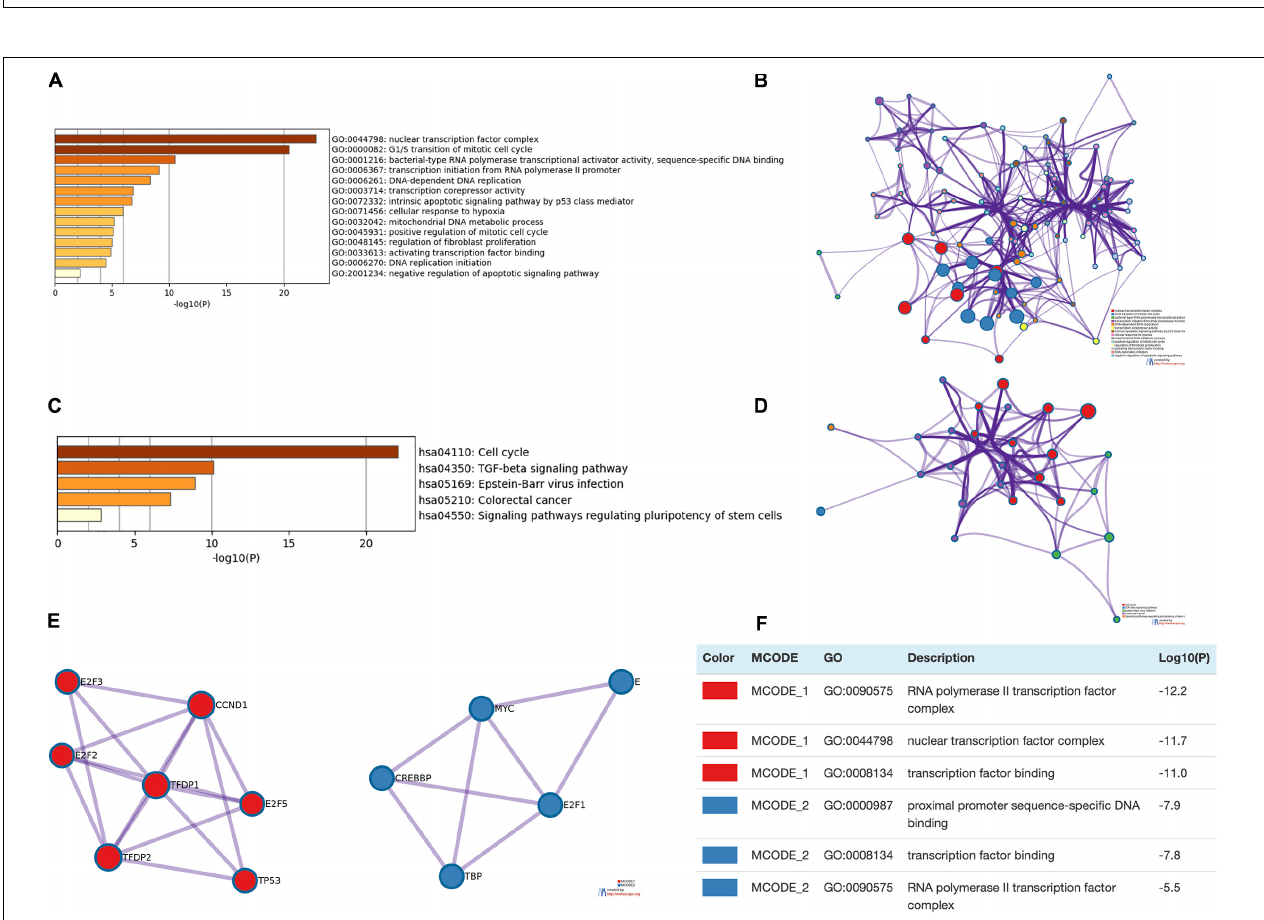
FIGURE 11 | A network of E2Fs with the associated neighboring genes. (A) Protein-protein interaction network of E2Fs. (B) Gene-gene interaction network of E2Fs.